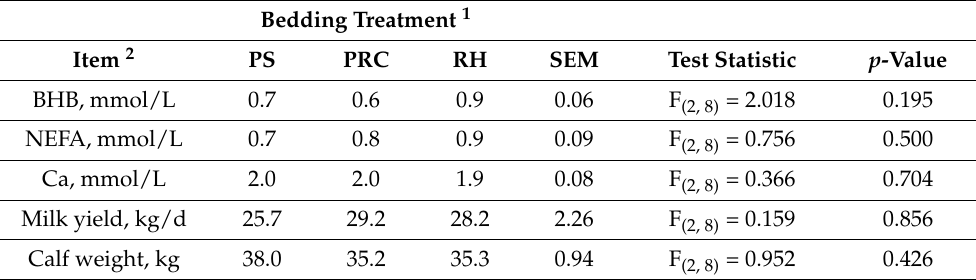
Table 7. Effects of three bedding materials on serum metabolites, milk yield, and calf weight of cows after calving in Experiment